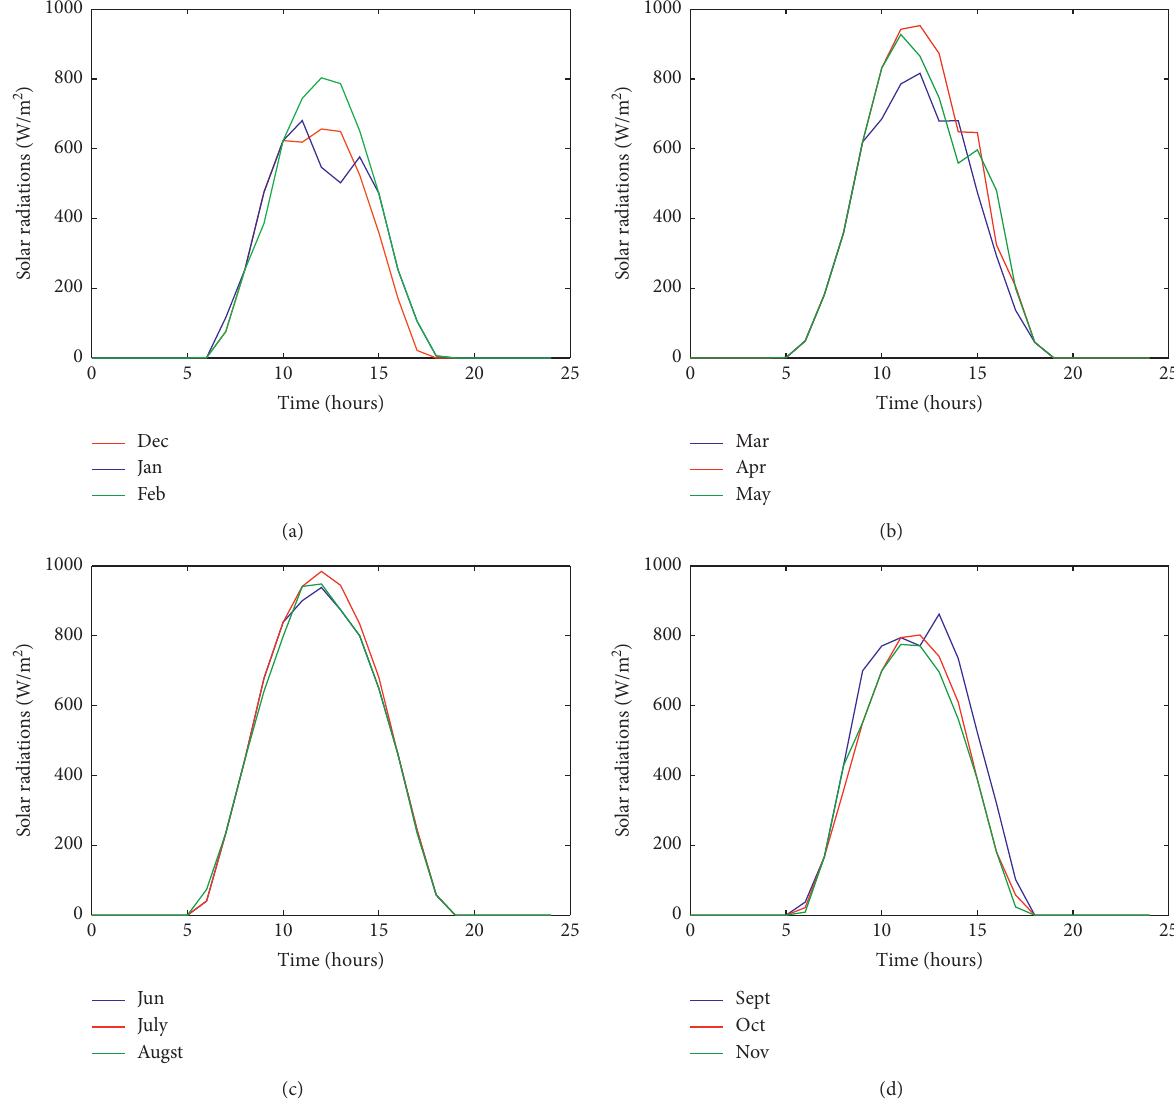
Figure 9: Solar irradiance of typical days for each month in seasons. (a) Winter, (b) spring, (c) summer, (d)